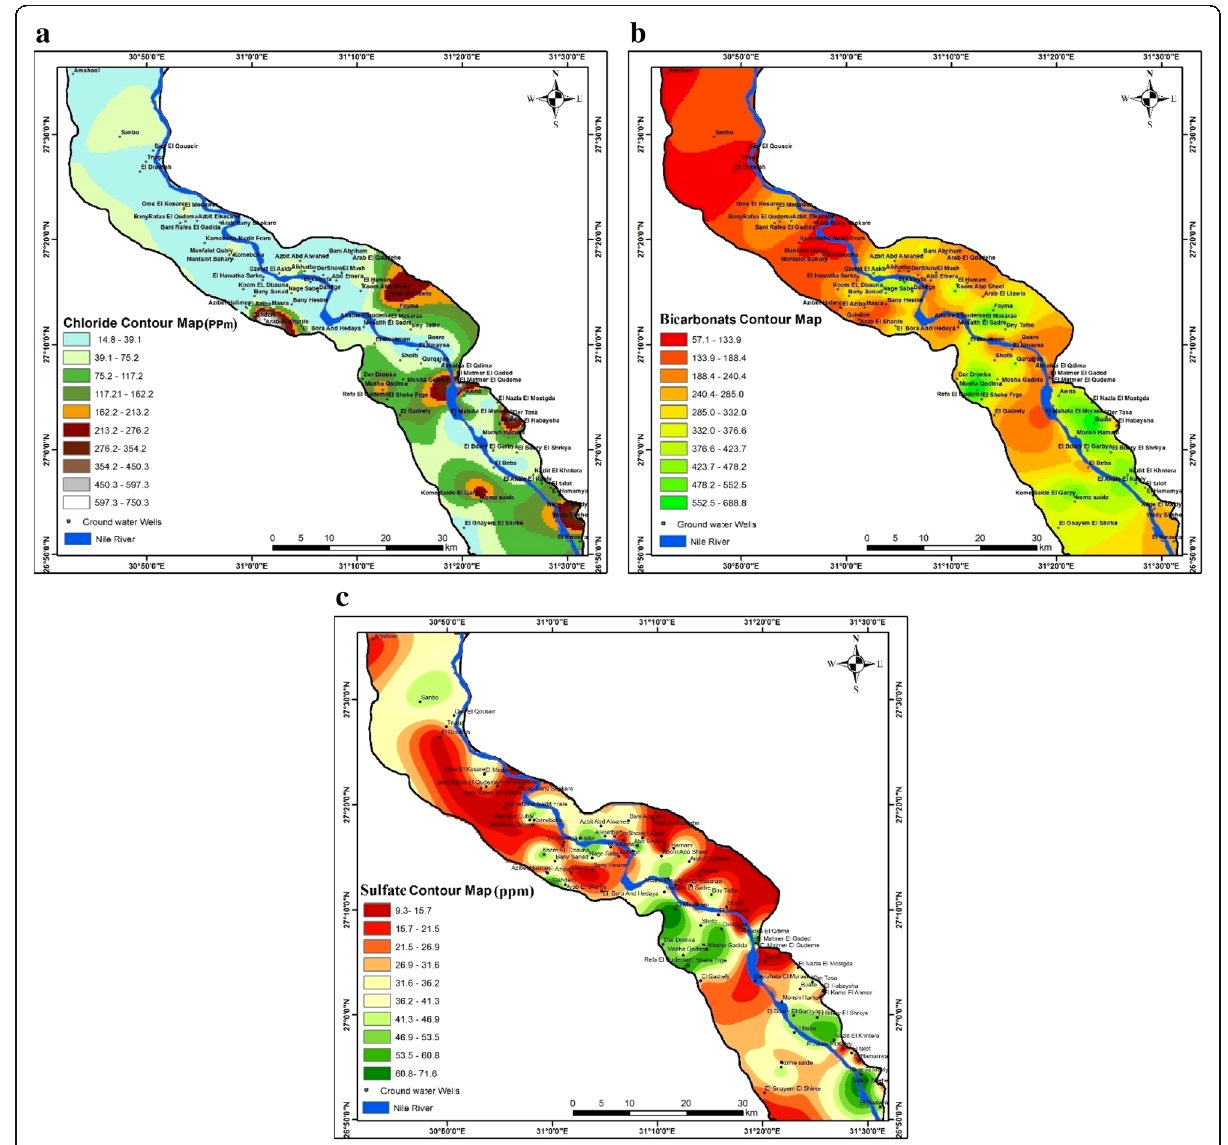
Fig. 10 Iso-concentration maps showing spatial variation in a Cl, b HCO 3 , and c SO 4 in the study area (values in milligrams per